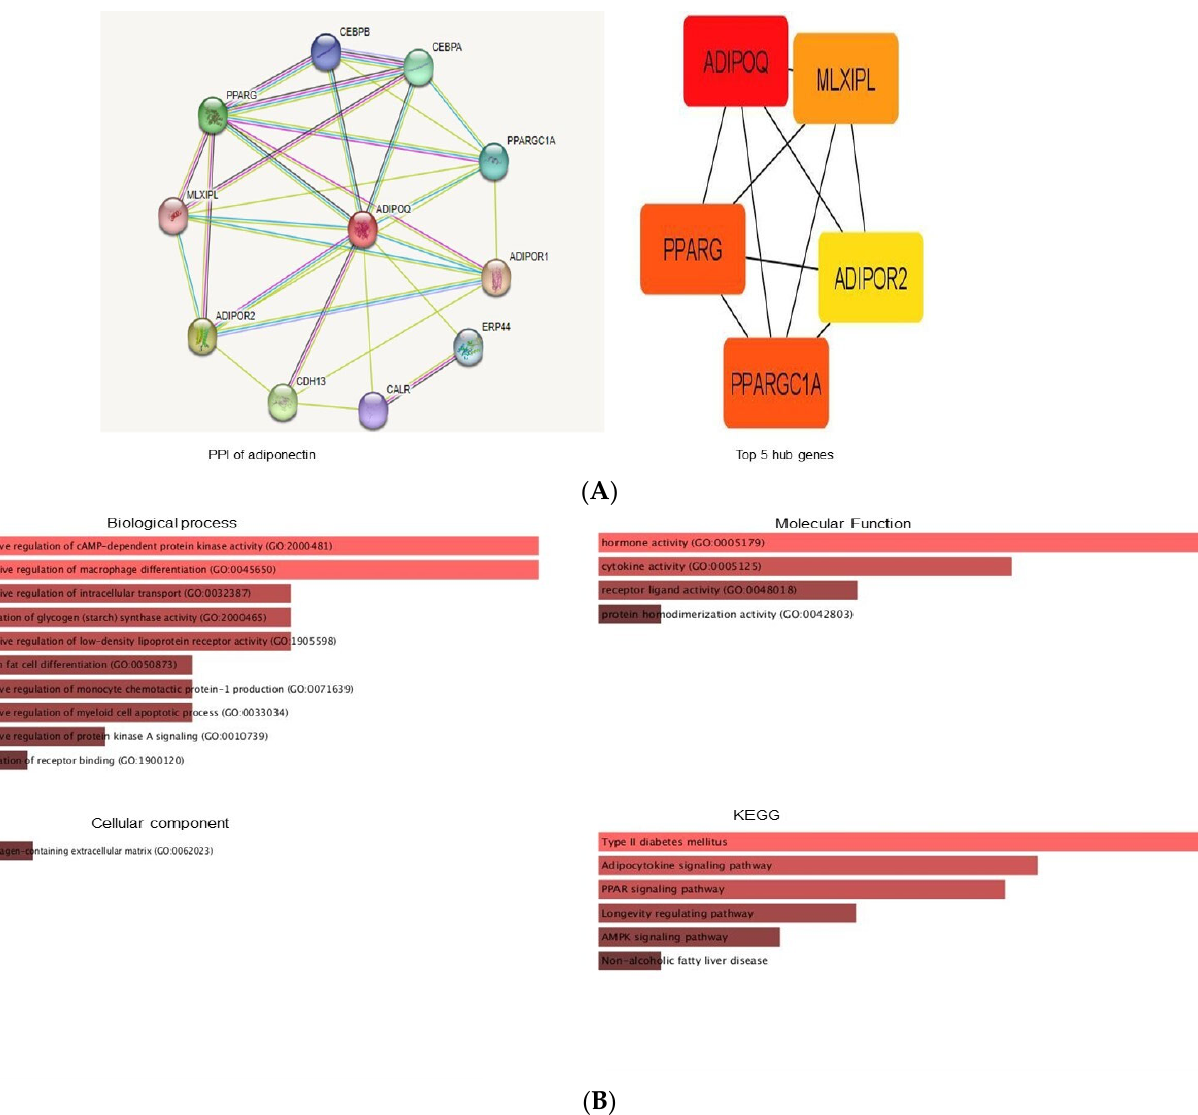
Figure 6. ( A ) PPI analysis of Adipoq. PPI constricted module of Adipoq using STRING and top 5 hub genes of PPI network identified using cytohubba. ( B ) Gene ontology functional analysis of the BP, MF, and CCanalyses of adiponectin and KEGG Pathway analysis.